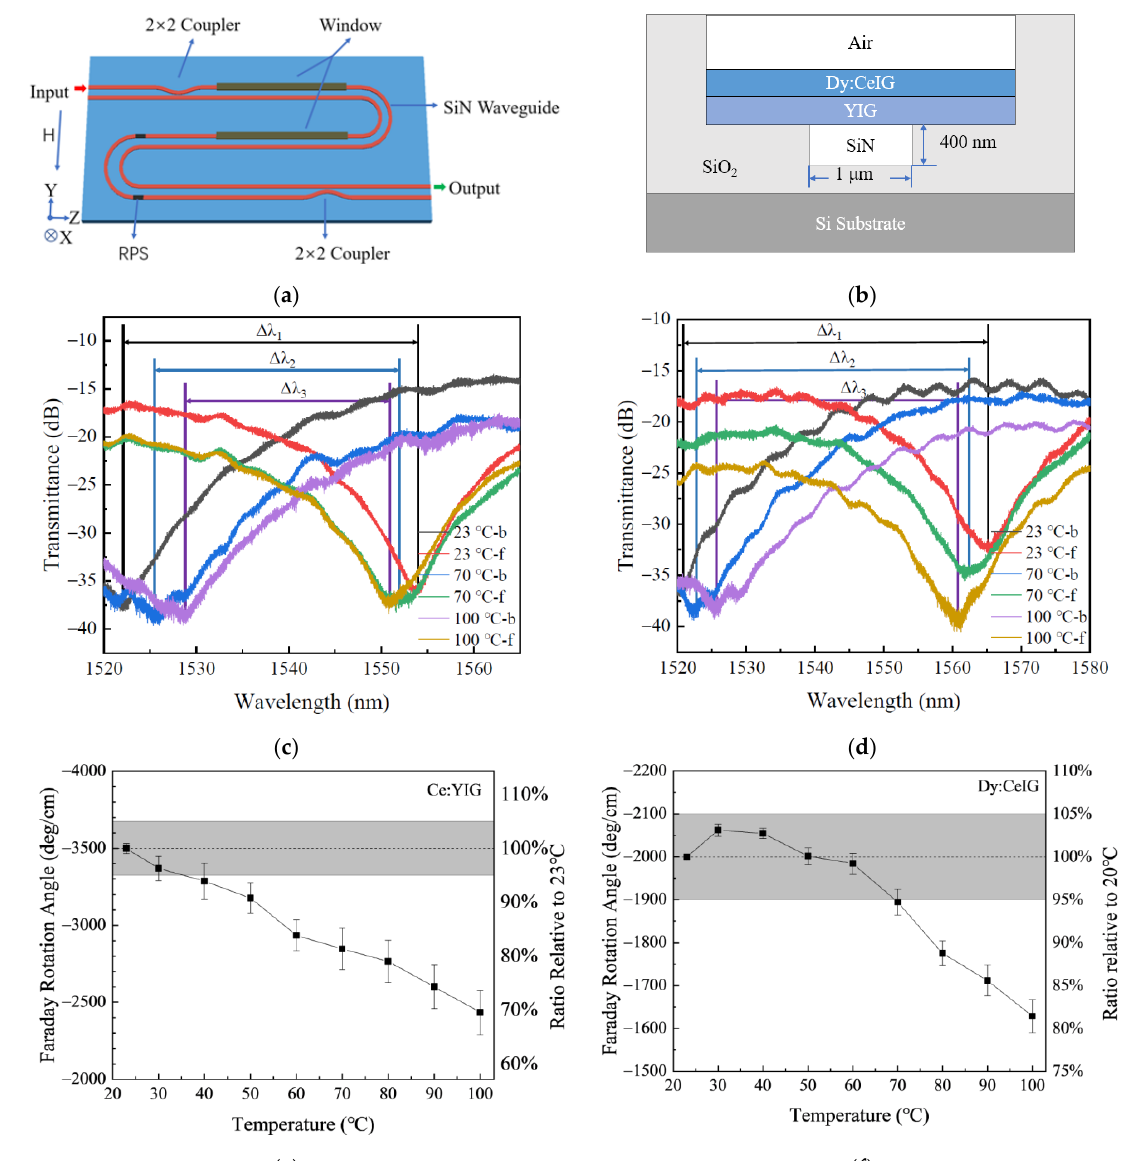
Figure 3. ( a ) Schematics of integrated magneto-optical isolators on SiN. ( b ) Cross section of MO/SiN waveguide. Transmission spectra of SiN optical isolators under different device temperatures of 23 °C, 80 °C, and 100 °C, respectively for ( c ) Ce:YIG and ( d ) Dy:CeIG. “f” and “b” correspond to forward and backward propagation light. Faraday rotation angle versus temperature resulting from transmission spectra, respectively for ( e ) Ce:YIG and ( f ) Dy:CeIG. The error bar is the standard deviation from three consecutive measurements of the transmission spectrum.